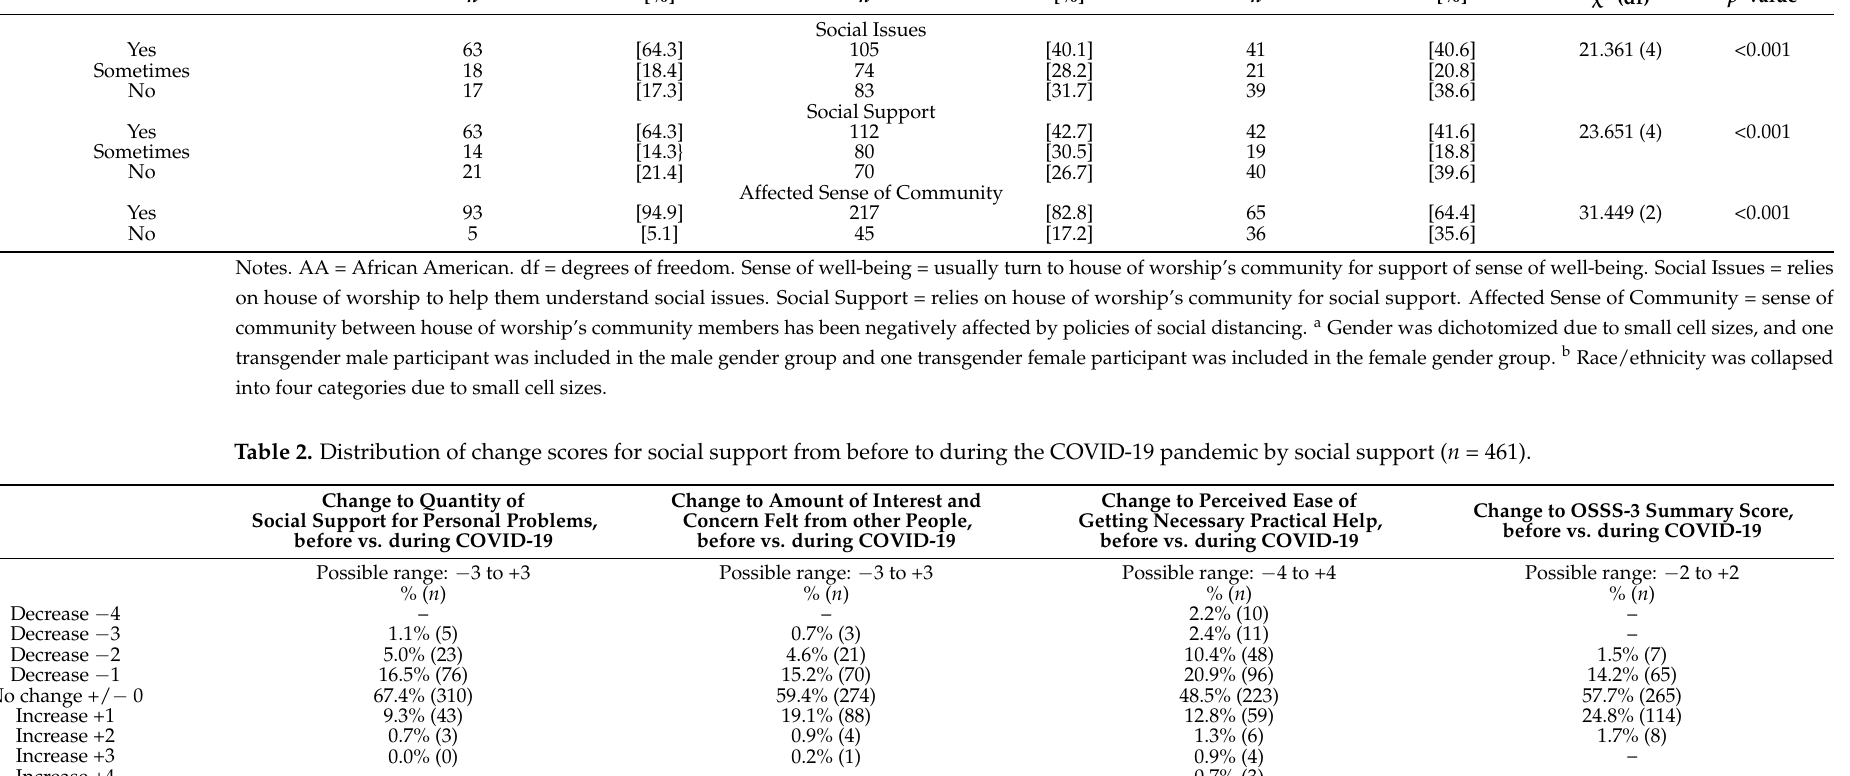
Continued Using Remote Worship Services (n = 98)